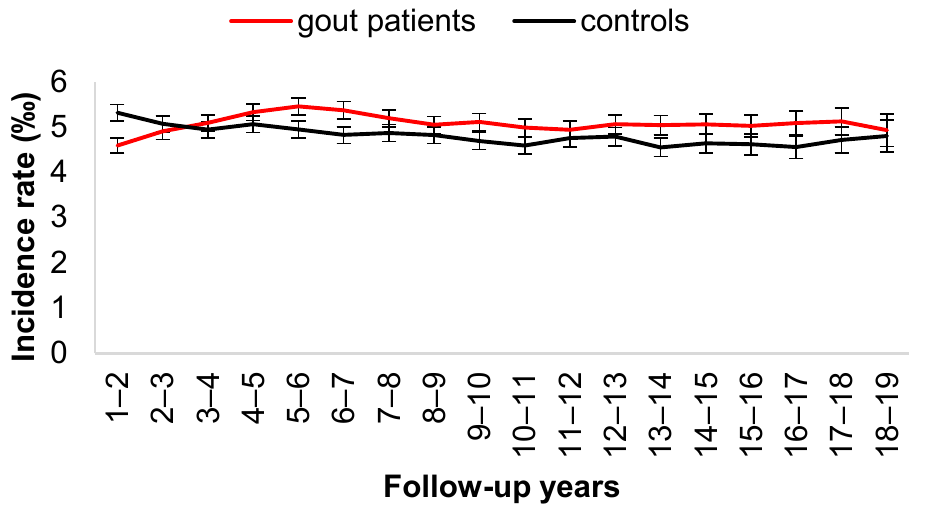
Figure 2. Two-year moving average of incident rate of ischemic